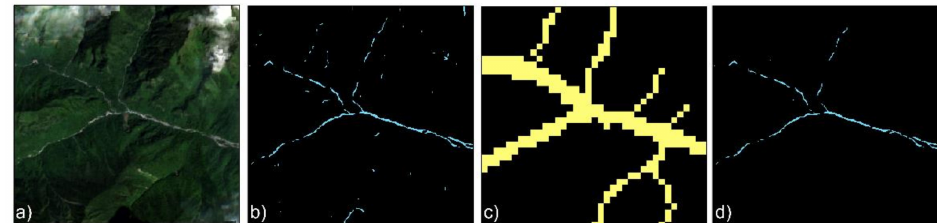
Figure 6. Classification removal based on DEM-modelled area of interest (AOI). ( a ) Original Sentinel- 2 image. RGB: band 4 (Red), band 3 (Green), band 2 (Blue). ( b ) Results before cropping. ( c ) AOI generated from HAND index. ( d ) Cropped